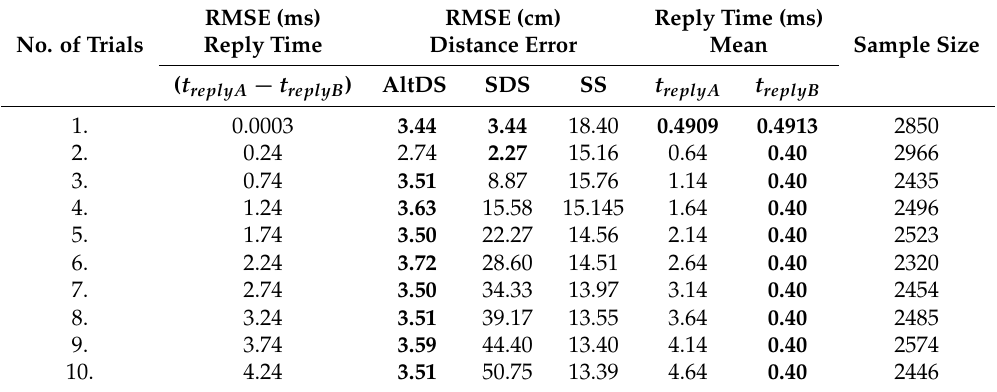
Table 7. Experimental evaluation results for variable reply times at fixed reference distance